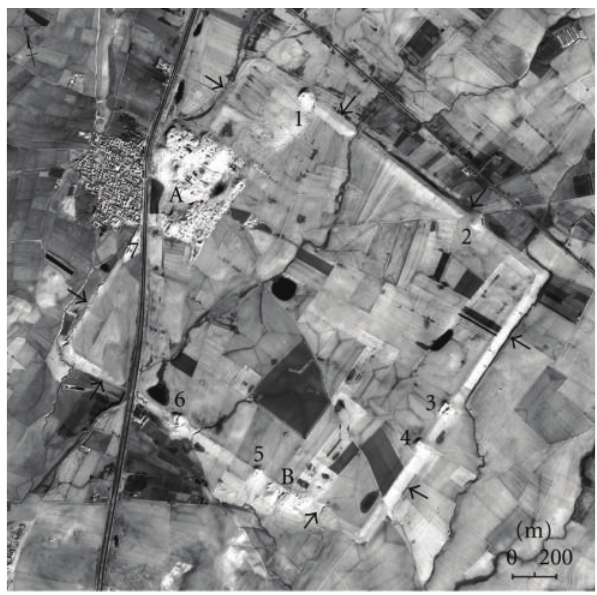
Figure 10: Dur-Sharrukin in an Ikonos-2 panchromatic image of 2001: (A) Palace of Sargon II; (B) Palace F; 1–7, gates along the city